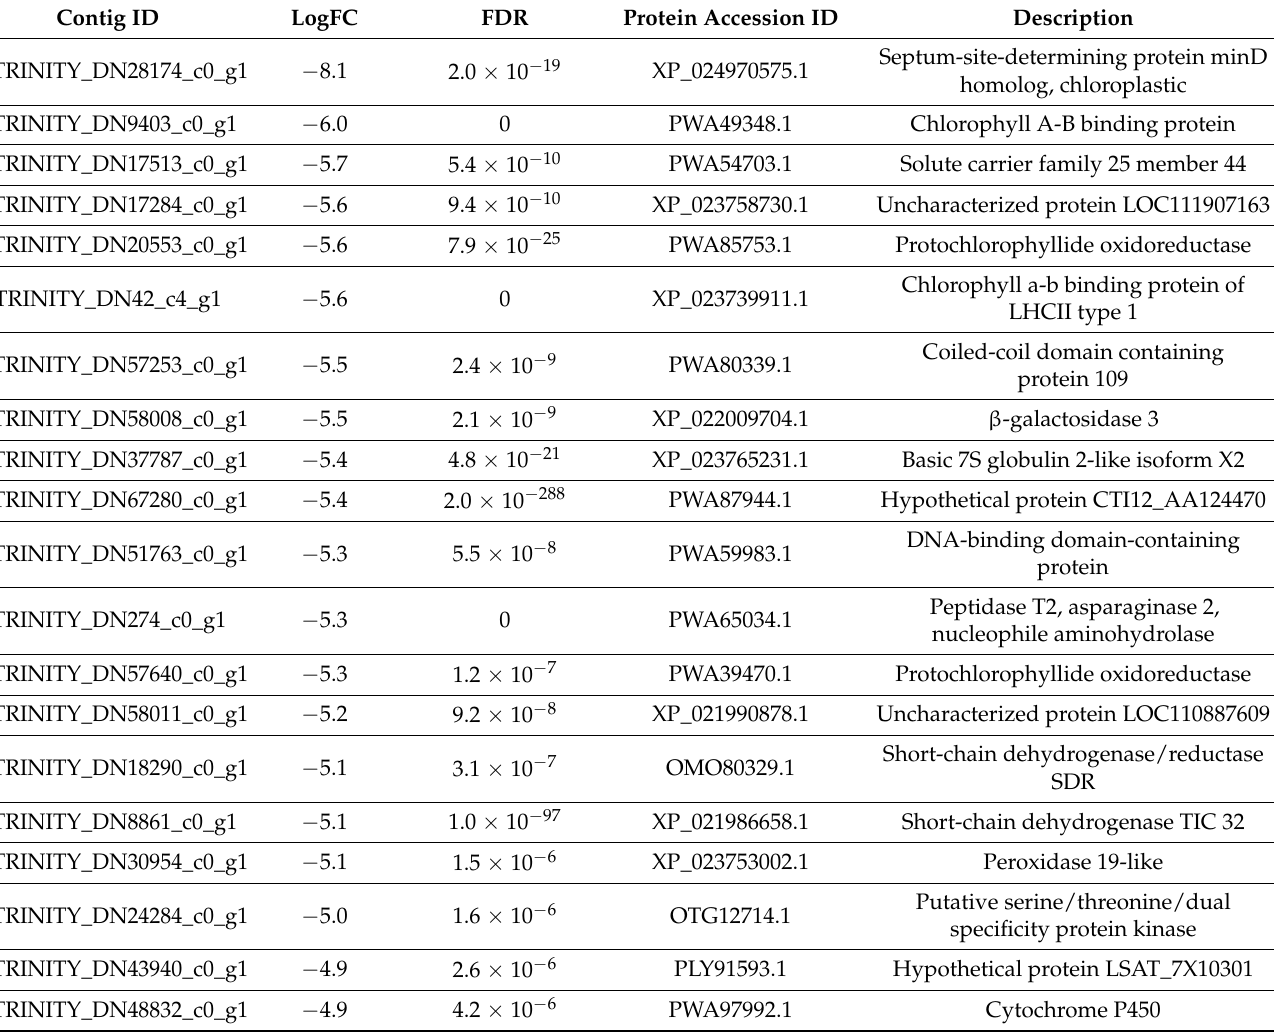
Table 5. The top 20 gene list of downregulated genes in TNSG vs. TNSC. De novo transcriptome and DEG analyses were performed by Trinity and edgeR with the same libraries as Table 4. A total of 2411 genes were significantly downregulated by glyphosate treatment in TNS (FDR < 0.05). The top 20 downregulated genes are listed. Contig ID LogFC FDR Protein Accession ID